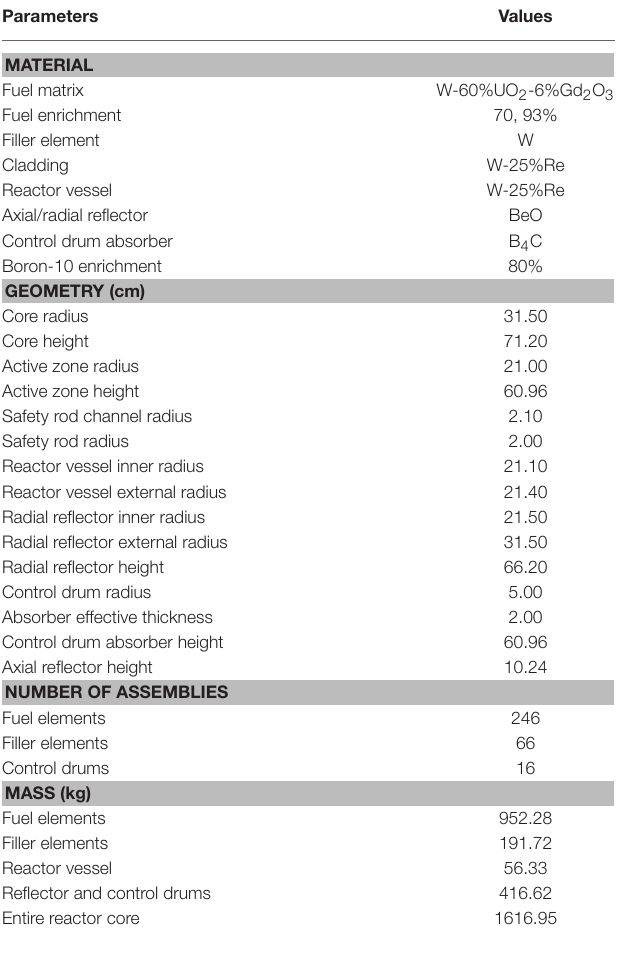
TABLE 3 | Major design parameters of the reactor core.